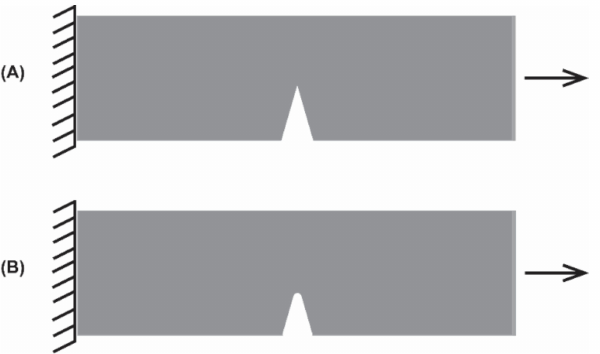
Figure 6. Theoretical examples of crack tips. ( A ) A sharp crack tip promotes rapid propagation of the crack. ( B ) A blunt crack tip slows the propagation of the